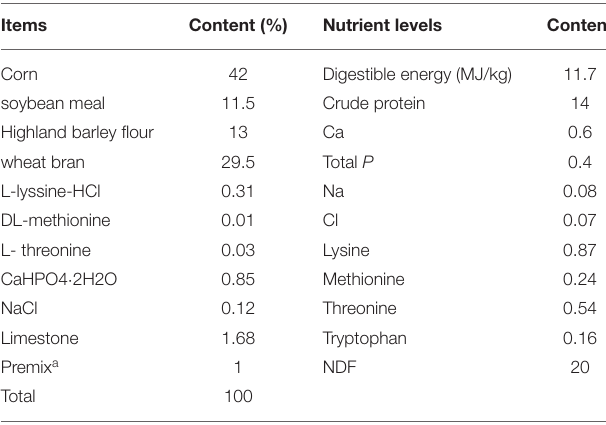
TABLE 1 | Basic diet compositions and nutritional levels.